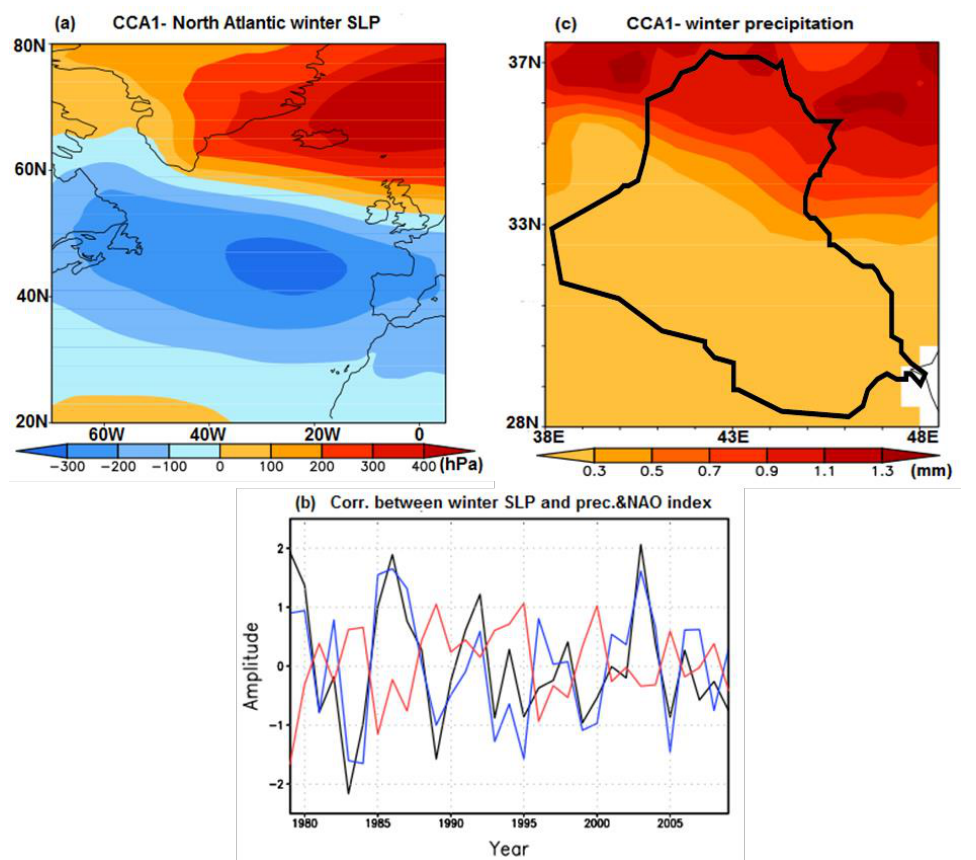
Figure 4. First pair derived through CCA between winter North Atlantic SLP and winter Iraq precipitation fields, extending over the 1979–2009 period. ( a ) SLP map, explaining 36.96% of the total variance; ( b ) SLP (blue line), Iraq precipitation (black line) time series associated to patterns in panels ( a , c ), the correlation between these two time series is 0.80; ( c ) precipitation map, explaining 17.71% of the total variance. The NAO index (red line in panel ( b )) is correlated with the SLP time series at the − 0.80 level. The black contour line in panel ( c ) marks the Iraq border.